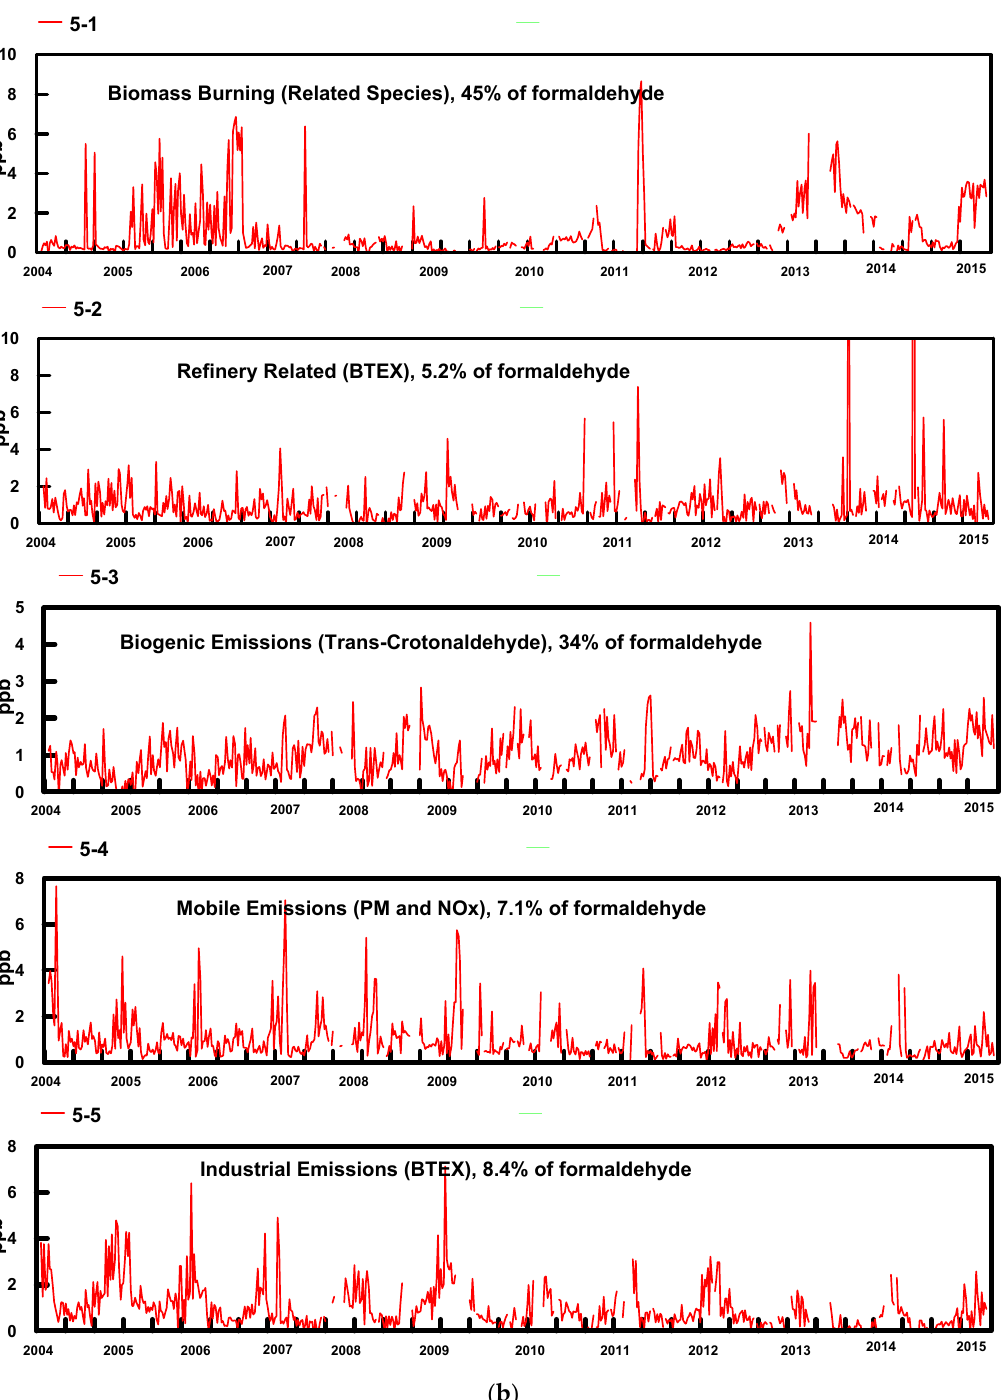
Figure 3. ( a ) PMF factor profile graph shows the concentration in ppbv (logarithmic scale) of each species apportioned to the factor (bars) and the percent of each species apportioned to the factor as a red box (red box); ( b ) Time series of factor contributions showing the start of each year.